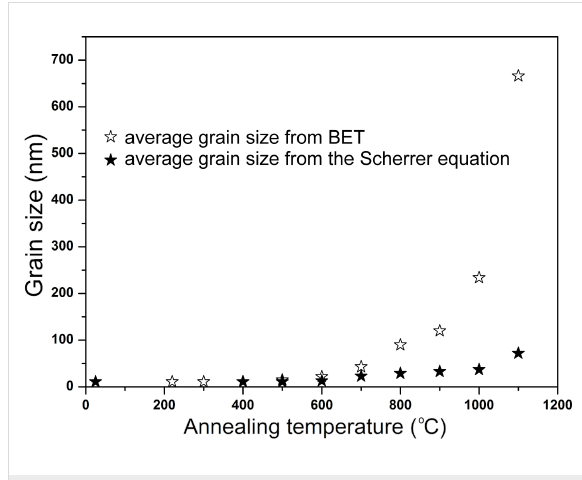
Figure 2: The average grain size of the ZrO 2 powder as a function of the annealing temperature.